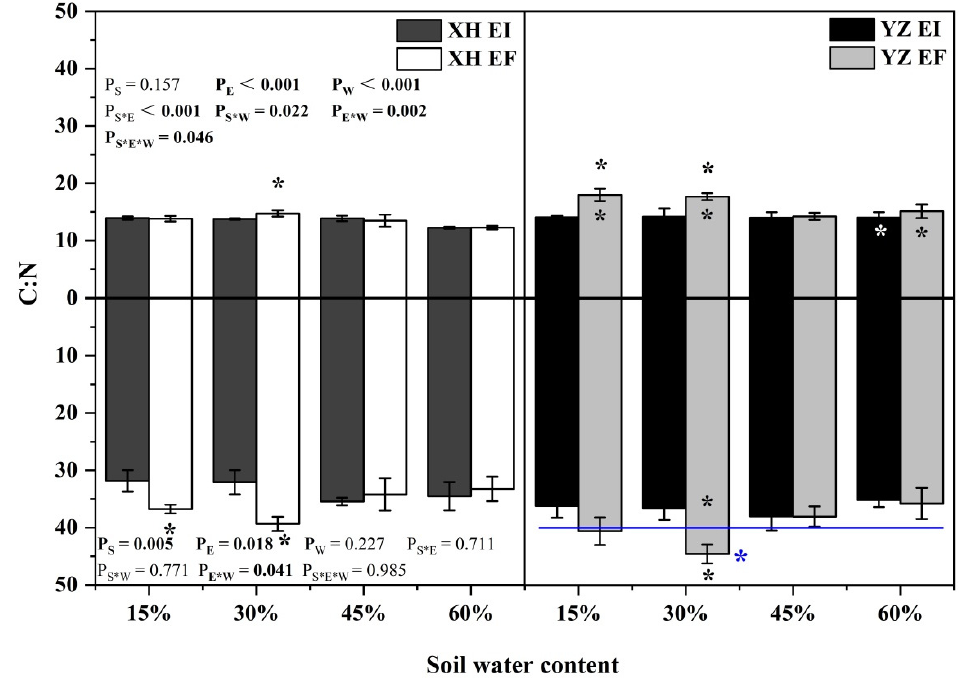
Figure 10. The C:N content of A. inebrians seedlings shoots and roots from XH(W) and YZ(D) seeds under various soil water content. Upwards and downwards bars represent the value of shoot and root part, respectively. The asterisk (*) above/below error bars means significant difference ( p < 0.05) between EI and EF under the same soil water content. White/black * in the black/gray bars indicates significant difference ( p < 0.05) between Xiahe and Yuzhong maternal habitat type of EF/EI grasses. The blue * above/below full blue line indicates significant difference ( p < 0.05) between Xiahe and Yuzhong maternal habitat type.